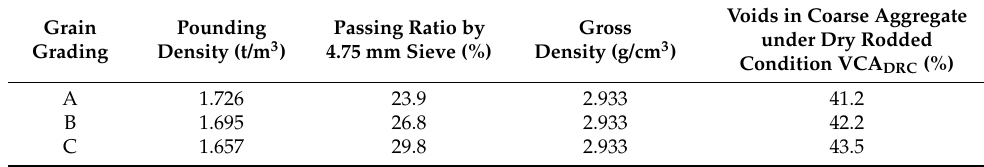
Table 6. The results of VCA DRC .